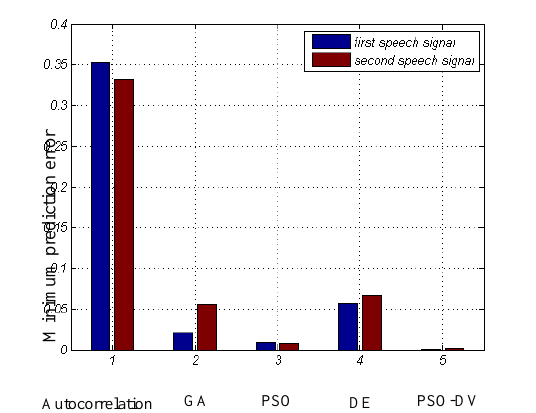
Figure 18. minimum prediction error achieved each various methods (frame 1 and